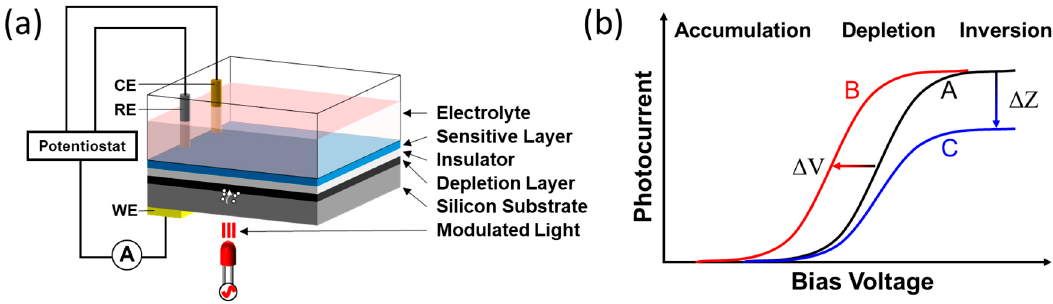
Figure 1. ( a ) Schematic of a typical LAPS set-up; ( b ) I-V curves representing the potential shift (LAPS) and impedance changes (SPIM).